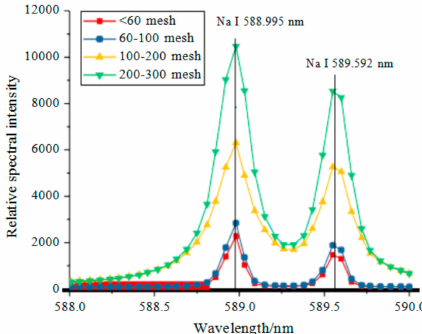
Figure 10. Spectral intensities of Na at 589